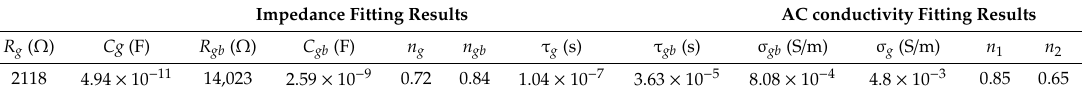
Figure 6. Complex impedance plane plot of PbS and Resistor-Capacitor circuit used for fitting. Table 1. Impedance and AC conductivity fitting results of PbS.